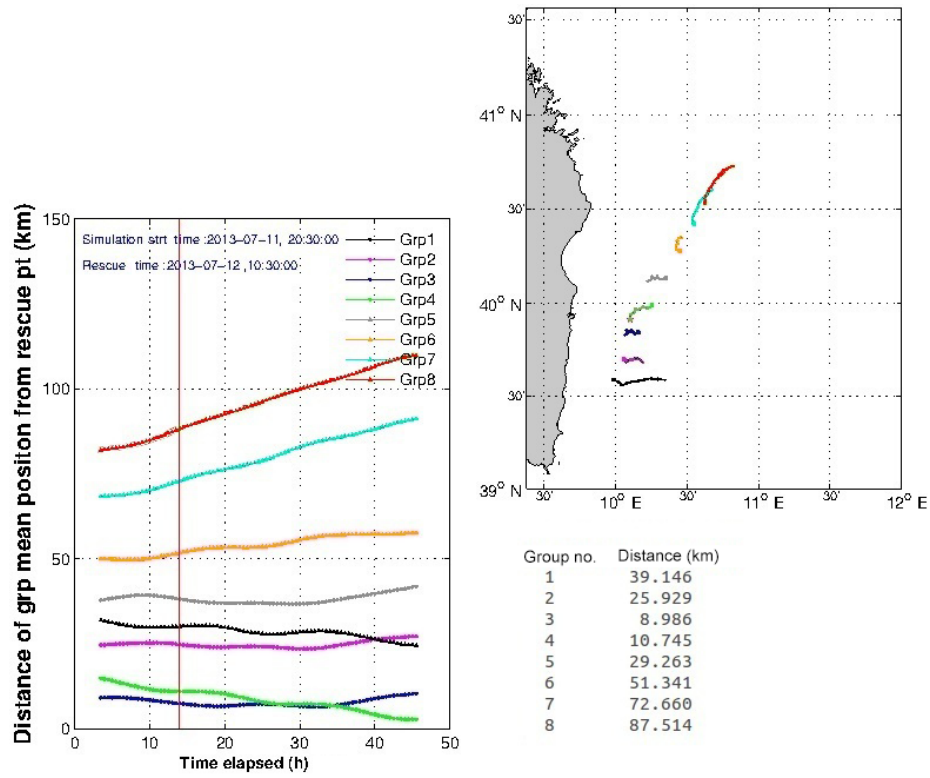
Figure 9. Distance of the mass center of each group planted every 30min from 20:30UTC (group 1) on 11 July 2013 to midnight the following day (group 8), corresponding to the solution in Fig. 8. Now the mass center of the third subset of particles (planted from 21:30 to 22:00UTC) has the smallest distance at the rescue time: it is about 8.9km and it is very similar to that of the first experiment. The smallest absolute distance is about 2.8km, estimated 31.5h later, and it belongs to the mass center of the fourth